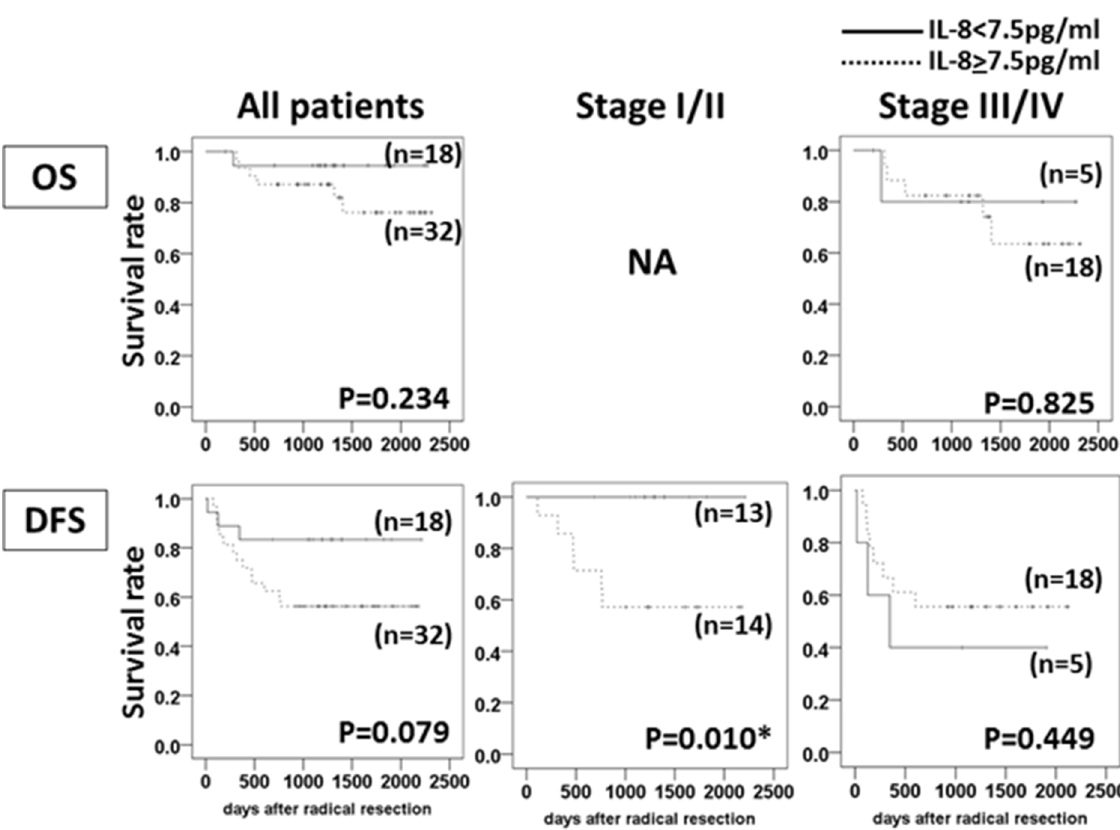
Figure 1. The relationship between serum IL-8 levels and the clinical outcome in OSCC patients who underwent radical resection of their tumor(s). The differences in the serum IL-8 > 7.5 pg/ml vs. IL-8 , 7.0 pg/ml in all patients, in the Stage I/II patients and in the Stage III/IV patients were calculated by log- rank test. * P , 0.05. NA: not analyzed because the number of OS events was only one.